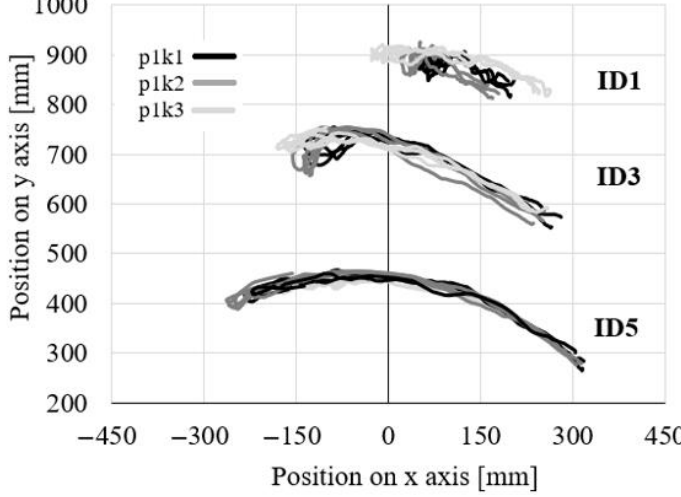
Figure 11. The displacement of individual markers for a constant gear ratio and a variable inclina- tion angle of the wheelchair.